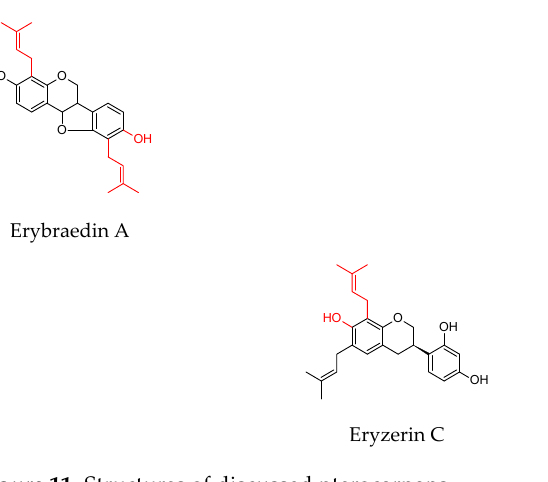
Figure 10. Structures of discussed chalcones.